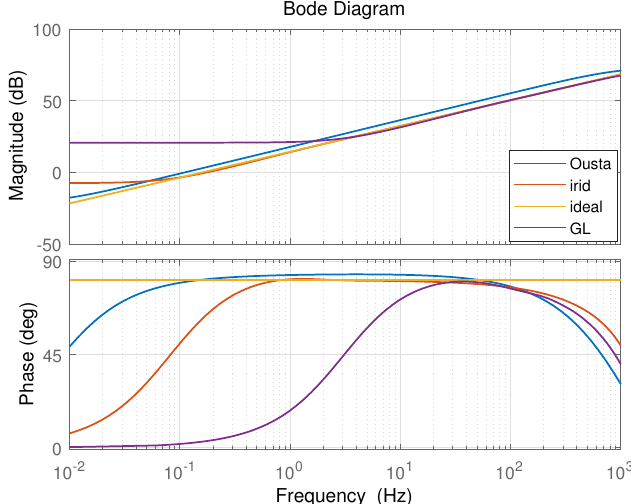
Figure 8. Case 5: 24th order discretization approximate Bode graph of s 0.9 in the frequency band [0.01, 1000]Hz.